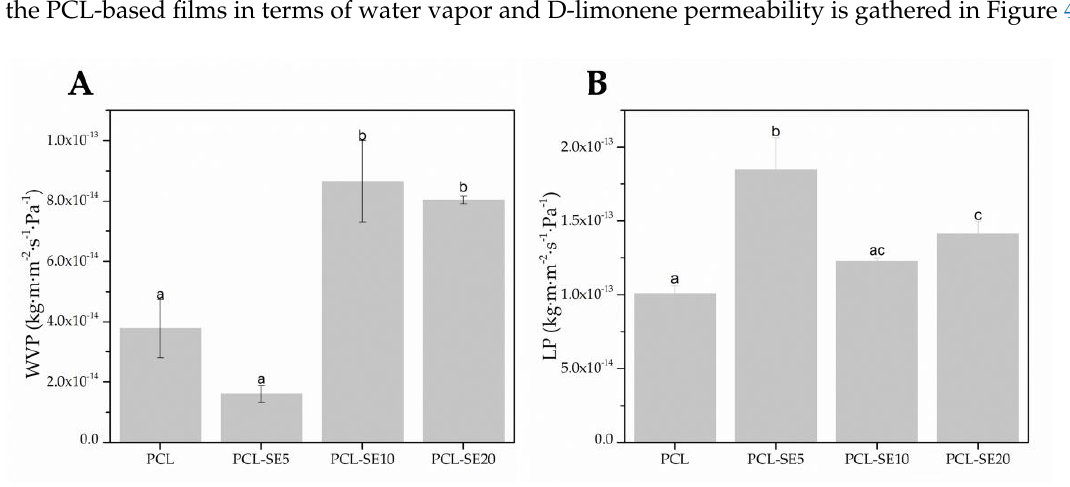
Figure 4. Water vapor (WVP) and D-limonene permeability (LP) of the poly( ε -caprolactone) (PCL)- based films. Different letters within the same column indicate significant differences among samples ( p < 0.05). Table 2. Mechanical properties in terms of elastic modulus (E), tensile strength ( σ b ), elongation at break ( ε b ) and toughness (T) of the poly( ε -caprolactone) (PLC)-based